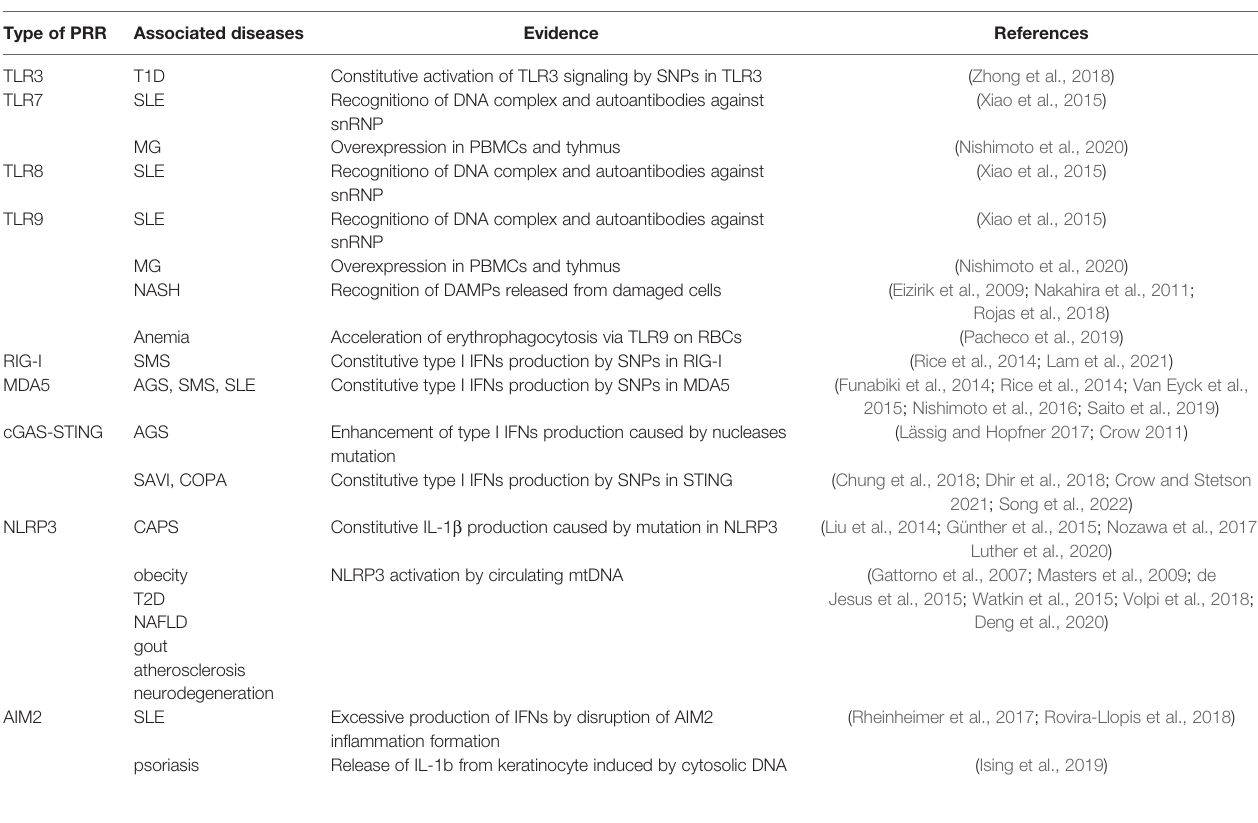
TABLE 1 | Nucleic acid-sensing receptor-related